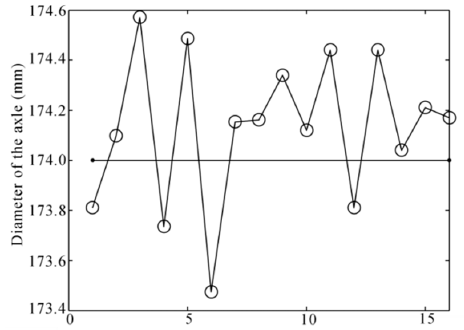
Figure 24. The diameter results of the wheelset axle.